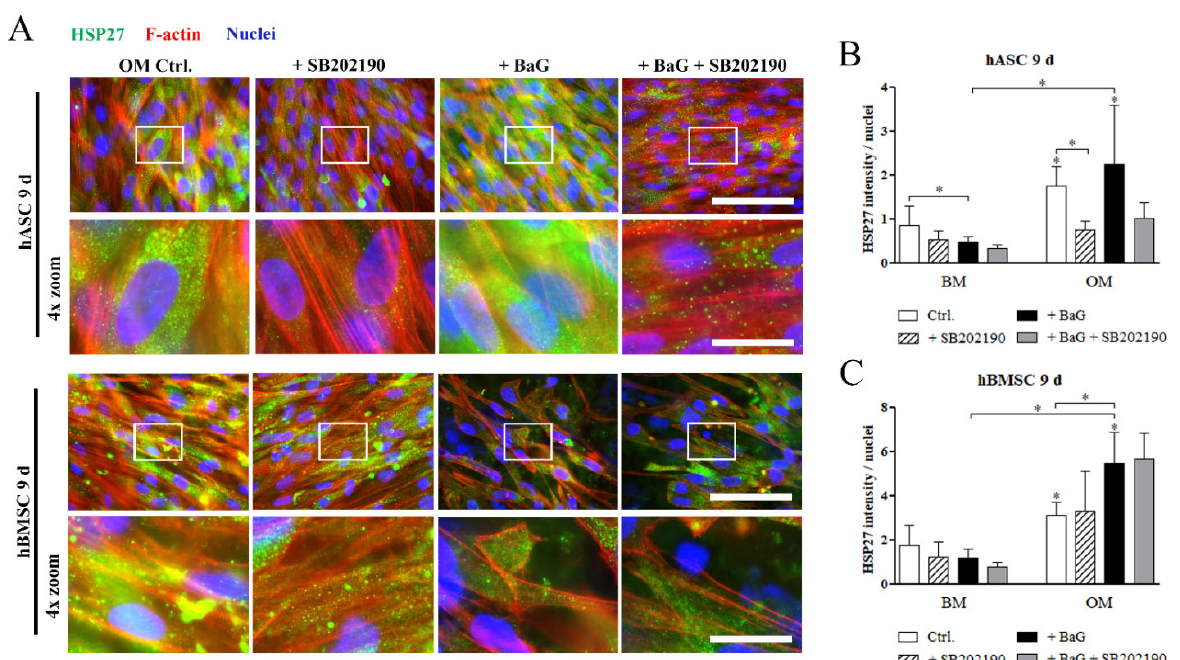
Figure 4. Cellular localization of basal HSP27 in hASCs and hBMSCs. ( A ) Representative images of HSP27-stained hASCs and hBMSCs after 9 days of culture in OM, and BaG OM supplemented with 3 µ M SB202190 inhibitor. Fluorescence images were taken with a 40 · magnification and with filters for HSP27 (Alexa 488, green), actin (Alexa 546, red), and nuclei (DAPI, blue). The 4 X digital zoom images are presented below the corresponding original images, indicated with white rectangles. Secondary antibody controls are presented in Figure S2b. Scale bars are 100 µ m in the original images and 25 µ m in the zoom images. ( B , C ) Image-based quantification of mean grey values of HSP27 stained hASCs and hBMSCs normalized with nuclei count. Statistical analysis: hASCs: N = 8–9 images, 2 independent biological replicates of 2 donors; hBMSCs: N = 7–8 images, 2 independent biological replicates of 2 donors. Representative images of hASCs and hBMSCs cultured in BM and BaG BM conditions are in Figure S6a. * p < 0.05. The asterisk above the error bar indicates the statistical difference compared to the BM control, and other comparisons are indicated with lines. Abbreviations: basic medium, BM; osteogenic medium, OM; and bioactive glass,